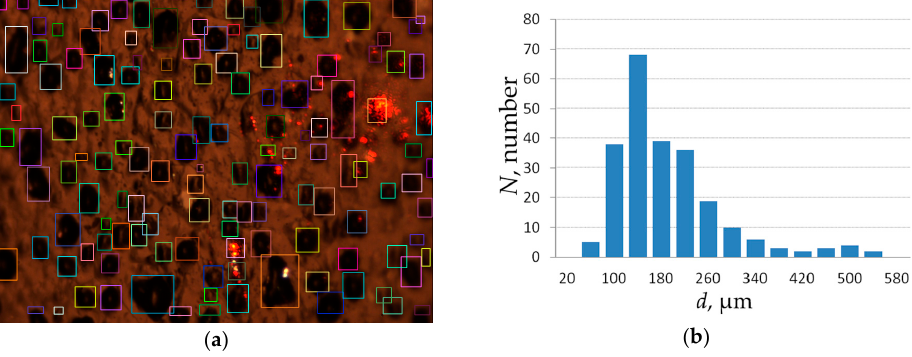
Figure 21. Result of image processing ( a ) and size distribution histogram ( b ) of blisters on the surface of 99.99996% fine-grained copper (Sample 4). The frame size of ( a ) is 9 mm horizontally and 4 mm vertically.